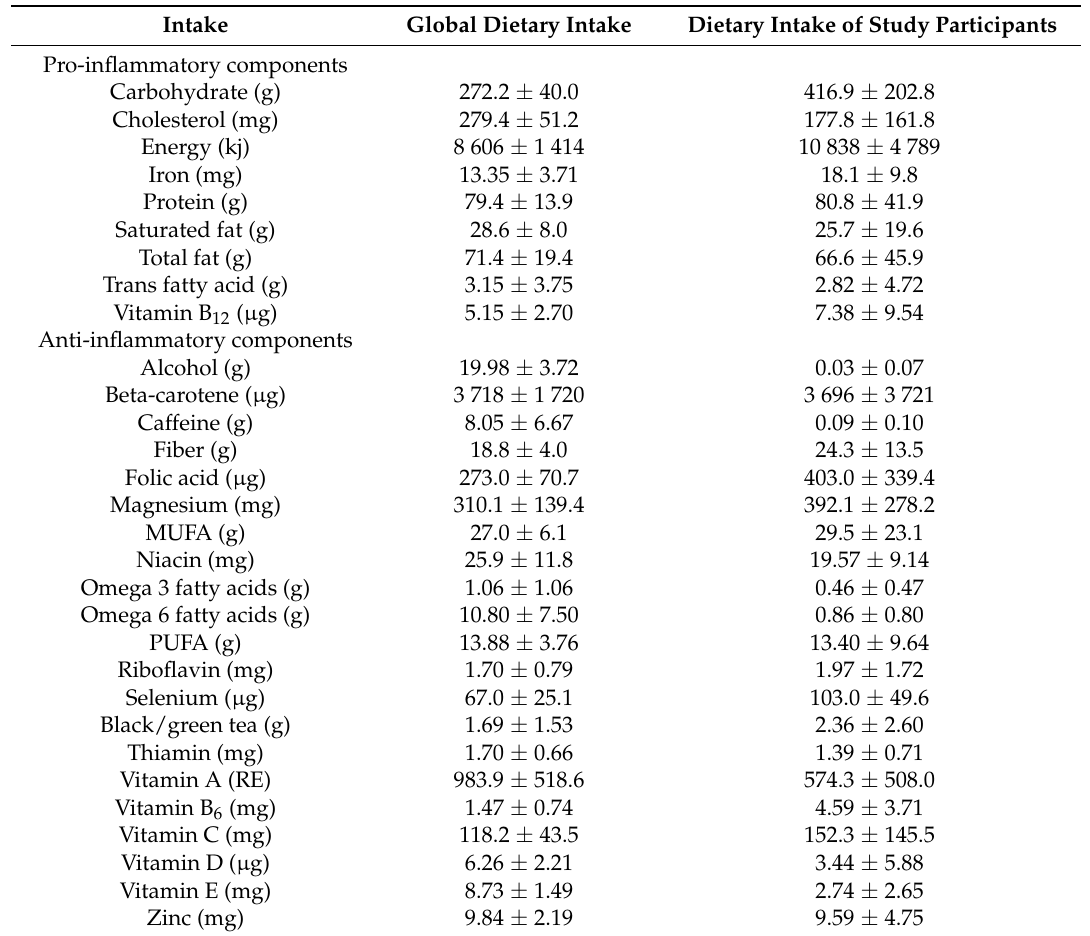
Table 2. Comparison of global dietary intake and dietary intake of Indonesian